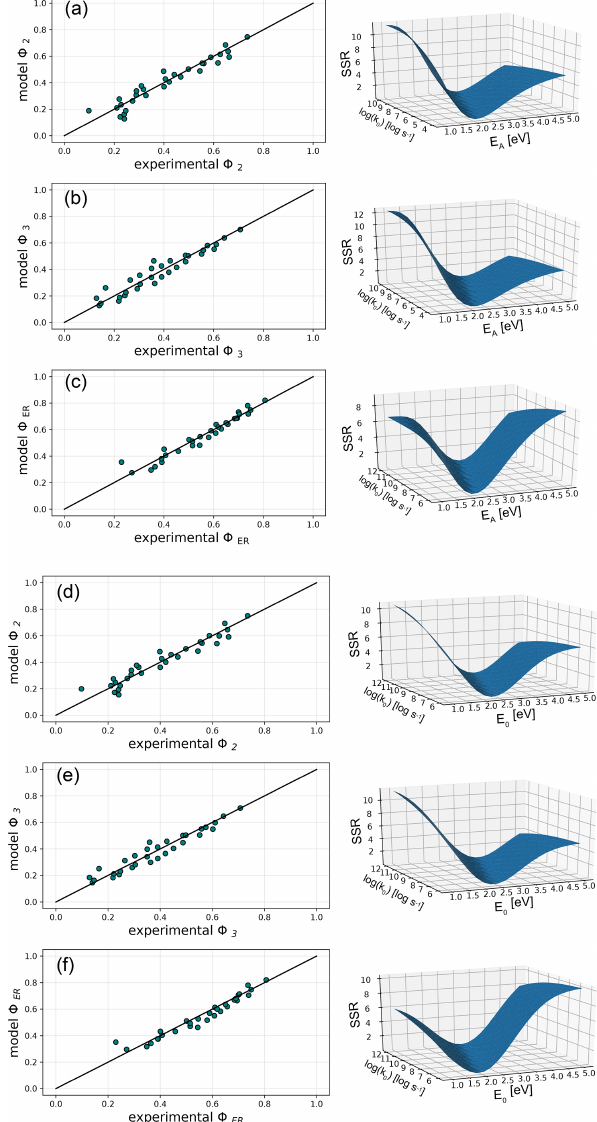
Figure 7. Plots of the annealed fraction (cid:56) against ln annealing time for the ν 2 (SiO 4 ) (a) , ν 3 (SiO 4 ) (b) , and ER (c) Raman bands. The arithmetic means are connected with lines for visual guidance.